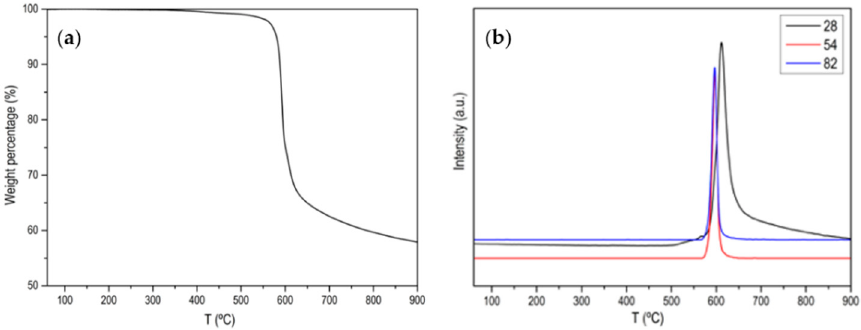
Figure 1. ( a ) Normalized TG profile of ZIF-67 in Ar atmosphere; ( b ) MS signal for m/z 28 (N 2 ), m/z 54 and m/z 82 (main 2-Methylimidazole fragmentations).